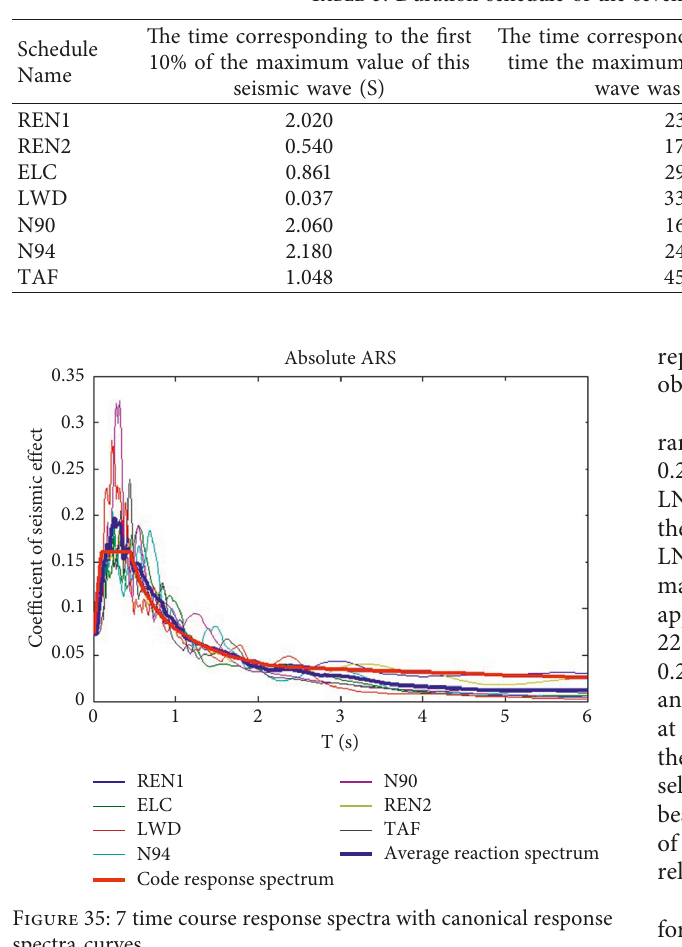
Table 5: Duration schedule of the seven time course response spectra.